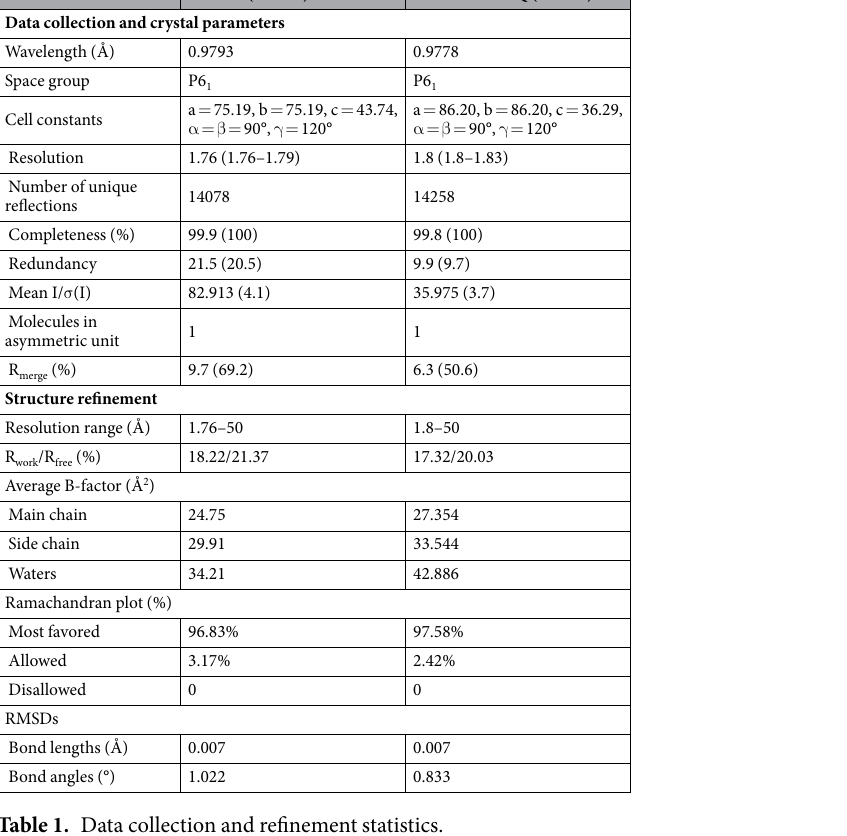
Table 1. Data collection and refinement